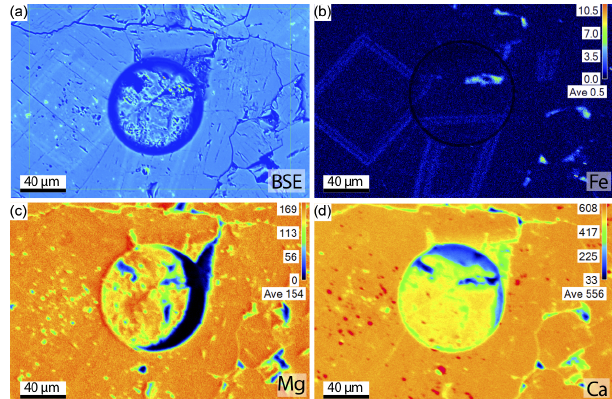
Figure 8. BSE image of an LA crater on sample KM-1 (a) com- pared with WDS elemental maps of the same location (b–d) . Zon- ing in the dolomite rhomb is highlighted by the Fe elemental map and absent on Mg and Ca. Mg-depleted and Ca-enriched clusters can be seen within the Fe rims of the dolomite crystals.